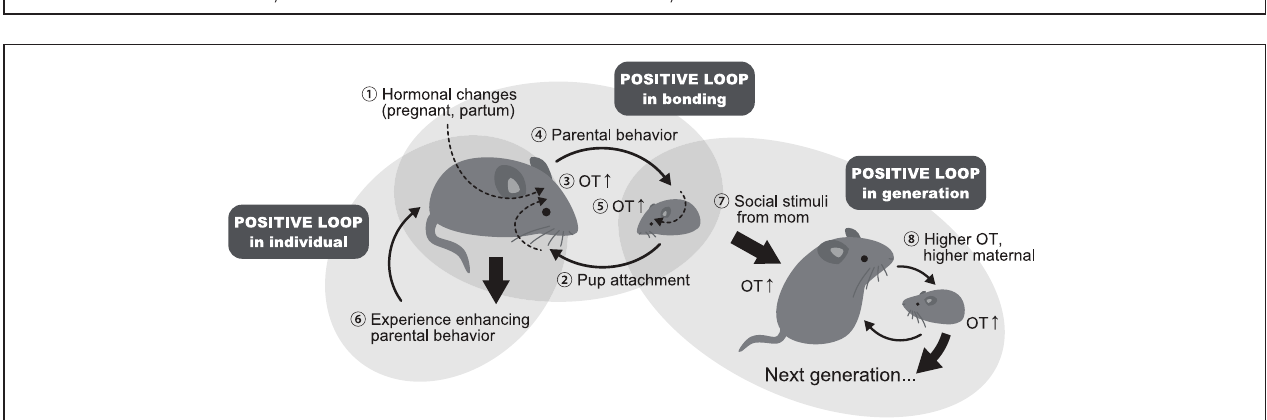
FIGURE 1 | Summary of the role of the oxytocin system in reciprocal communication. Central oxytocin release is stimulated by multiple sensory signals, such as olfactory, auditory, visual, and physical inputs. In particular, physiological stimuli are known to induce oxytocin system activation in mammals. When oxytocin release is increased in the central